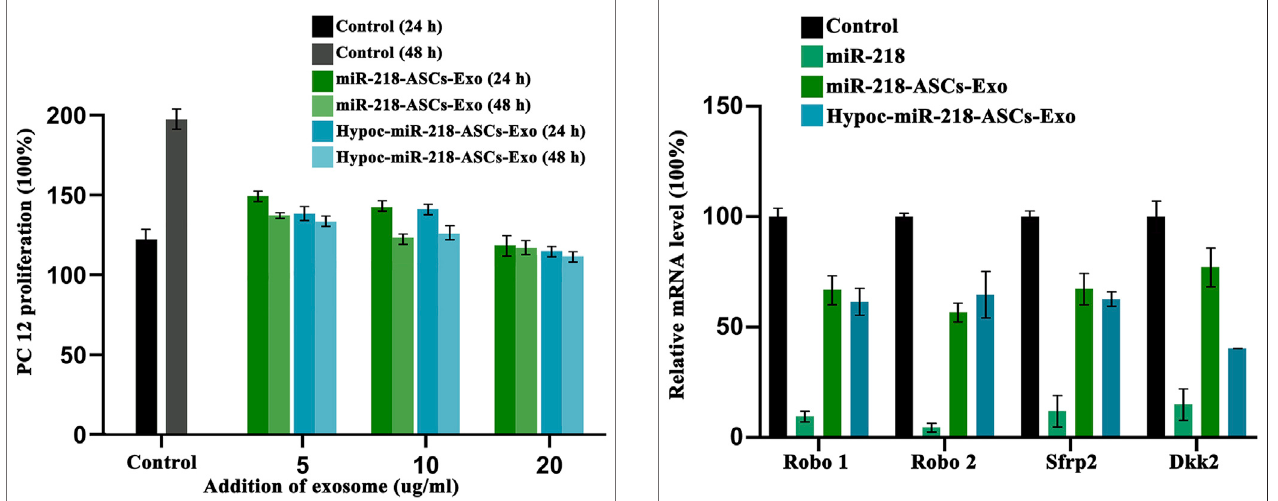
FIGURE 9 | PC12 proliferation was tested after the cultured medium was added to 5 µg/ml, 10 µg/ml, and 20 µg/ml exosomes. Untreated PC12 cells served as the Control group. Expression levels of miR-218 targeted genes ( Robo 1 , Robo 2 , Sfrp 2 , and Dkk 2 ) were examined by qRT-PCR in untreated PC12 cells (Control group), PC12 cells of transfected miR-218 plasmid, and two exosomes groups.